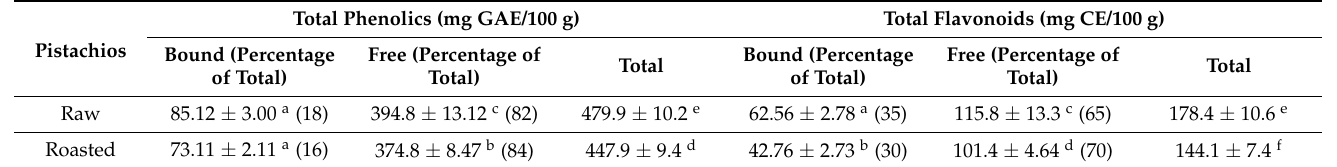
Table 1. Total phenolics contents of pistachios (raw and roasted).